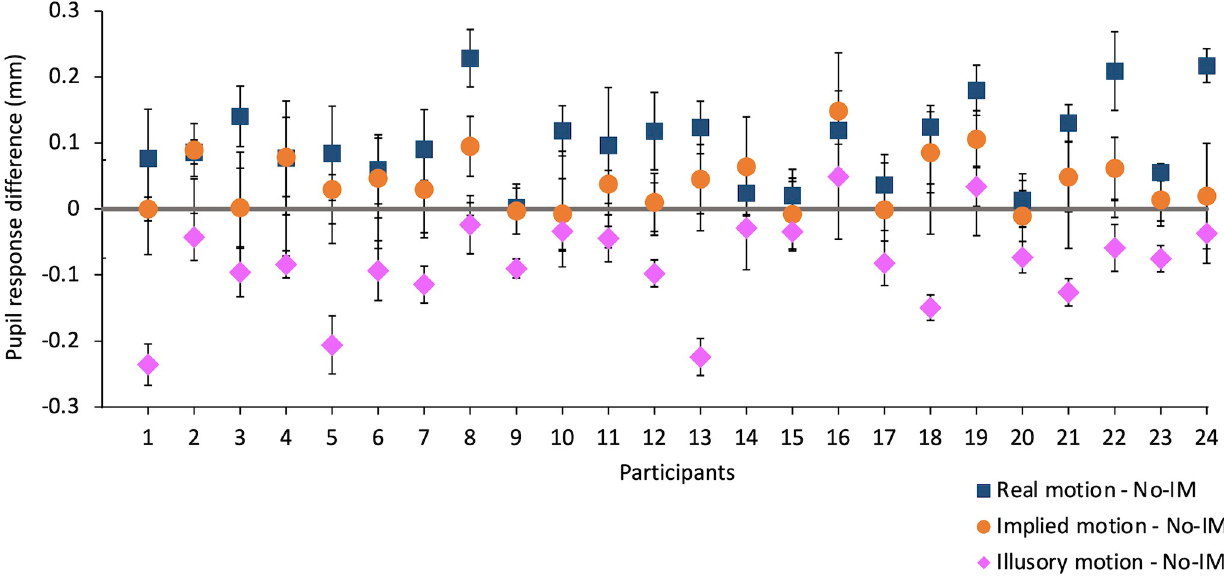
Fig 3. Individual differences between responses to no-implied motion vs real, implied, and illusory motion. Blue squares: differences between average pupil response to movies and photos with No-IM; orange circles: differences between average pupil response to photos with IM and photos with No-IM; purple rhombuses: differences between average pupil response to motion illusions and photos with No-IM. Error bars are the errors on the differences.